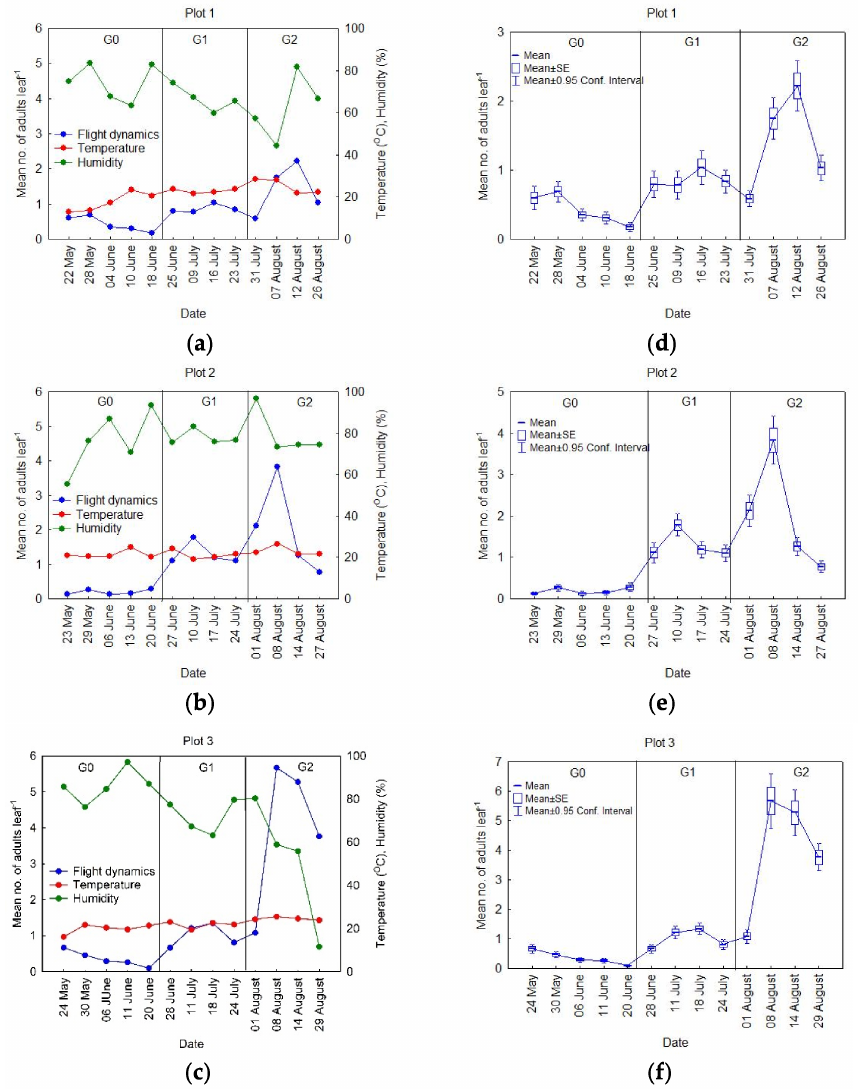
Figure 2. Seasonal dynamics of OLB populations in the studied tree plots: ( a – c ) variation in flight dynamics and meteorological factors: ( a ) Plot 1, ( b ) Plot 2, and ( c ) Plot 3. ( d – f ) Dynamics of OLB population variability: ( d ) Plot 1, ( e ) Plot 2, and ( f ) Plot 3. G0 = overwintering population; G1 = first generation; G2 = second